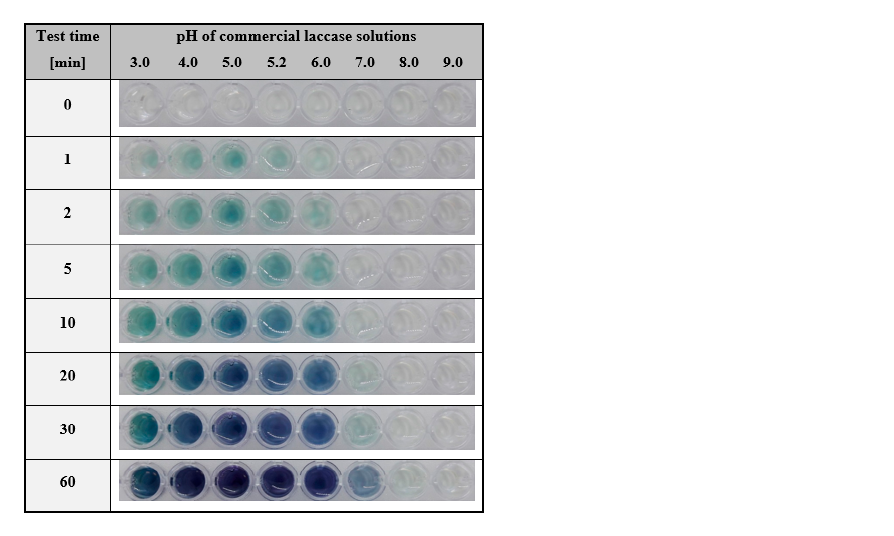
Figure 4. Visual response of the assays in a hydrogel matrix with immobilised ABTS (1.5 mg/mL) obtained after exposure time between 0 and 60 min for laccase solution (100 µg/mL) prepared in the citrate-phosphate buffer with pH ranging from 3.0 to 9.0.